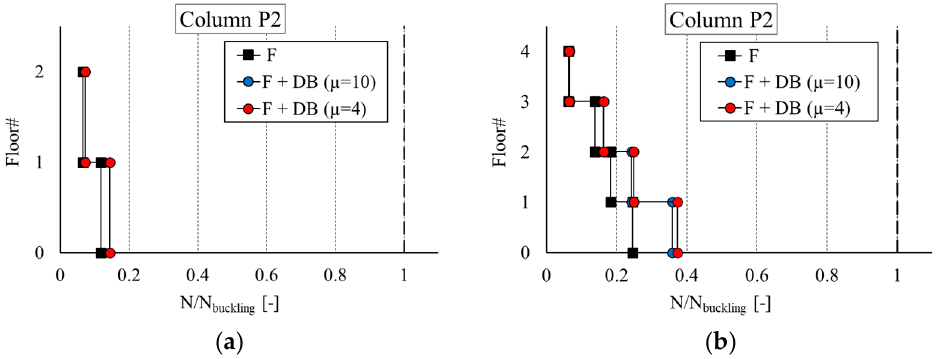
Figure 14. Buckling checks in the most stressed column in ( a ) two-story MRF and ( b ) four-story MRF.